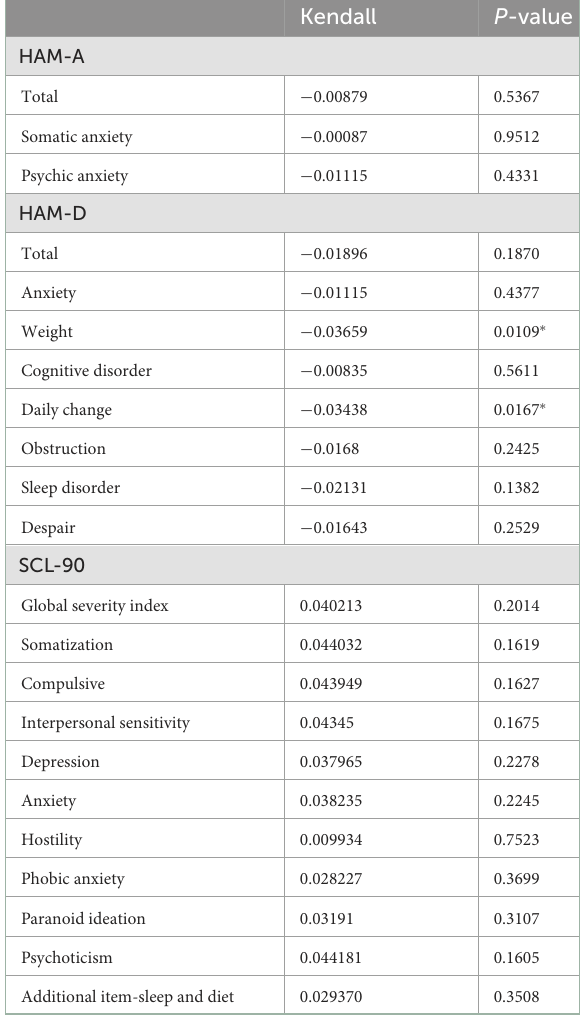
TABLE 5 Kendall’s tau coefficient analyses of diagnostic groups.